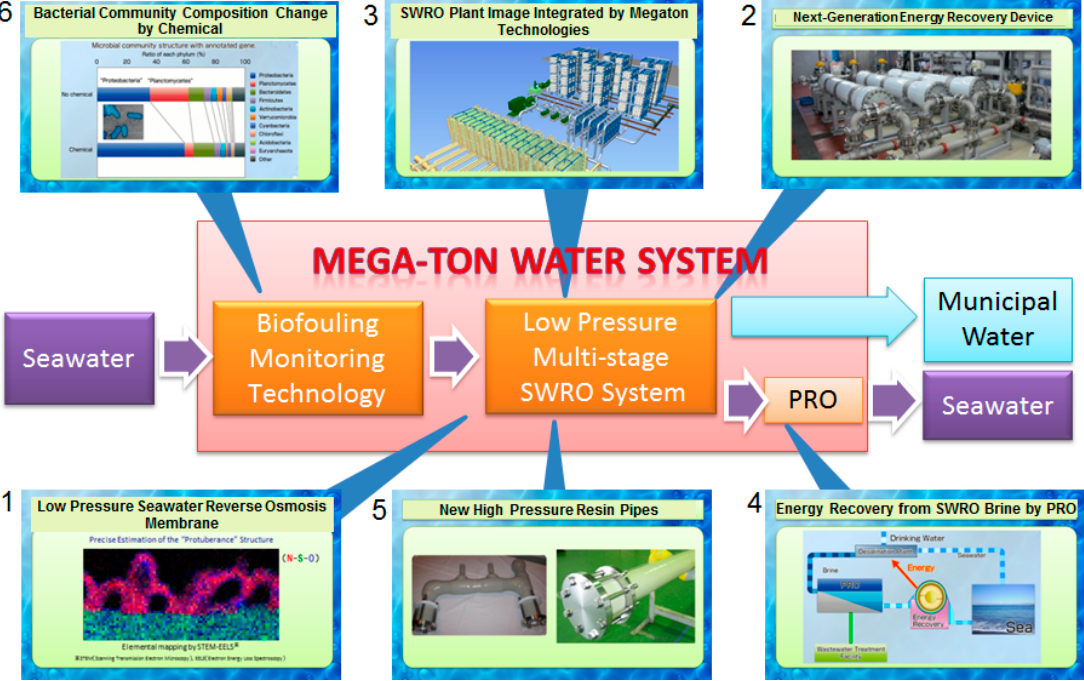
Figure 3. Outputs of “Mega-ton Water System” as six indispensable technologies for the 21st century.